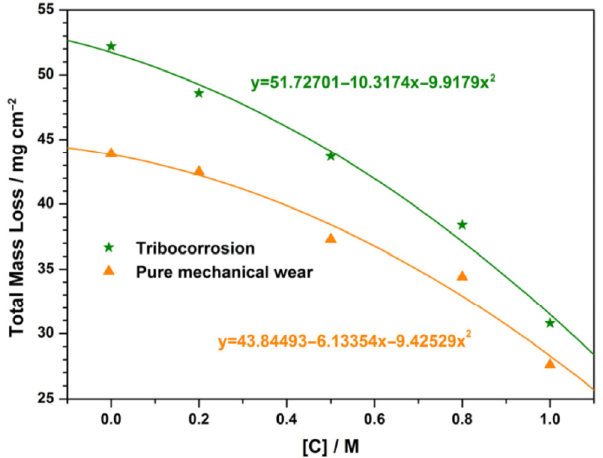
Fig. 5 Total mass-loss curves for NAB alloy in seawater with different halide-ion concentrations.